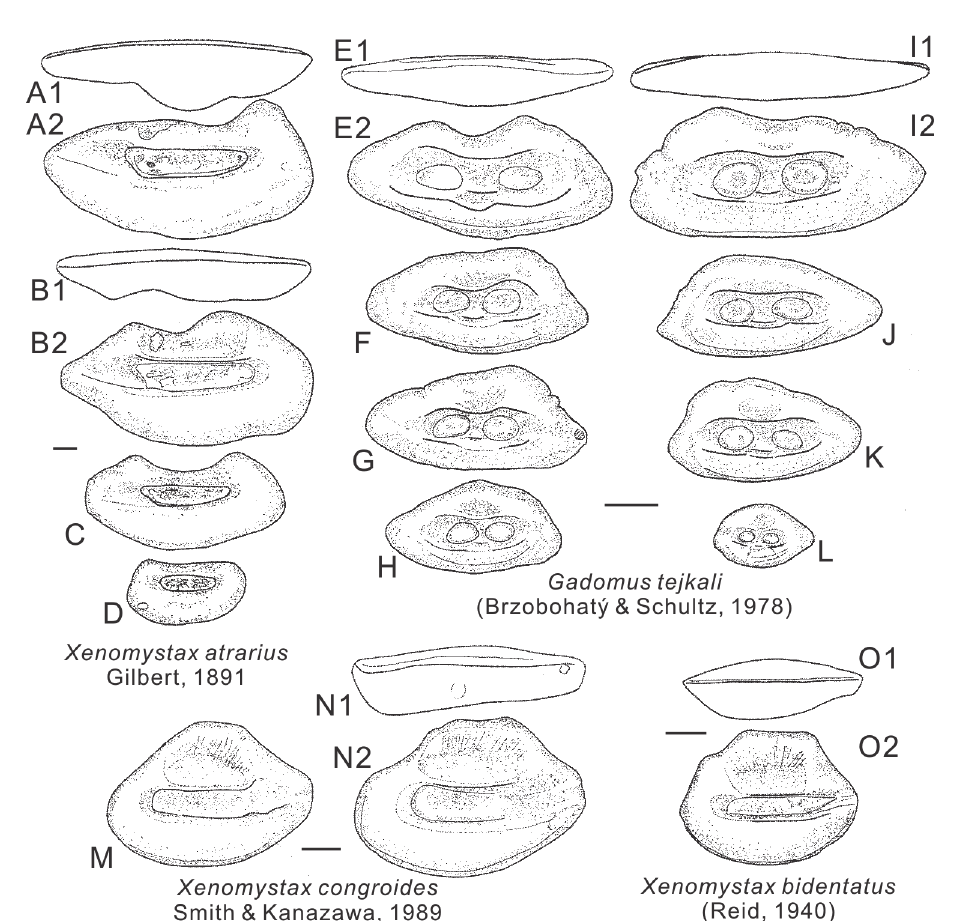
Fig. 3. A–D , M–O . Recent otoliths of species of Xenomystax Gilbert, 1891. A–D . X . atrarius Gilbert, 1891 from Peru, fish total length (TL) 81 cm, 72 cm, 57 cm and 43 cm, respectively. M–N . X . congroides Smith & Kanazawa, 1989, from off Mississippi. O . X . bidentatus (Reid, 1940), from the Caribbean Sea, TL 48 cm. – E–L . Fossil otoliths of Gadomus tejkali (Brzobohatý & Schultz, 1978) (IRSNB P 9847–P 9854) growth series from Roddi (E) and Mondovi, Madonna della Neve (F–L). 1 = ventral view; 2 = inner view. Scale bars = 1